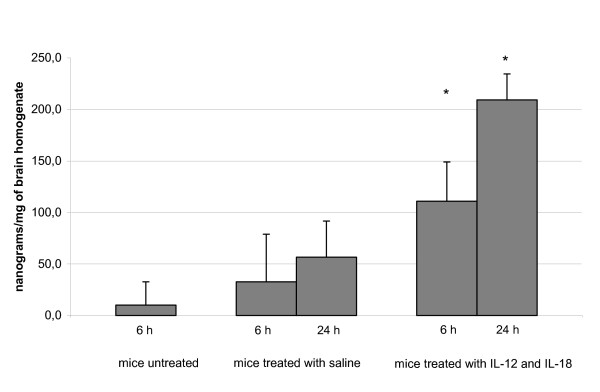
IFN-γ production. IFN-γ production, detected in brain homogenates, from untreated mice or mice intracerebrally inoculated with saline or IL-12 and IL-18, sacrificed at different time after treatment. * values statistically different from those obtained in mice treated with saline at the same time.